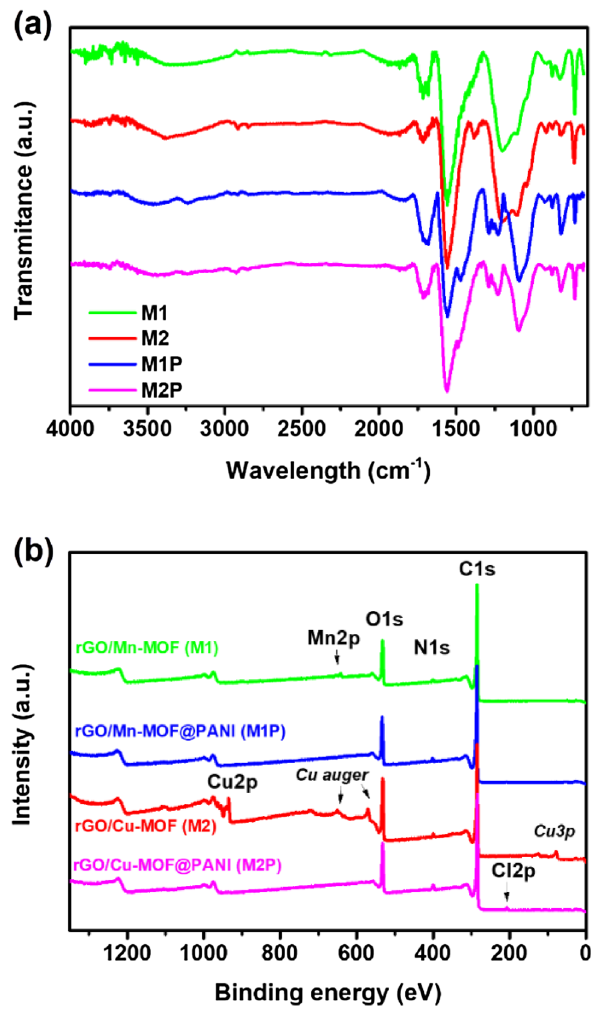
Figure 3. ( a ) FTIR spectra; and ( b ) XPS survey spectra of M1, M2, M1P, and M2P.